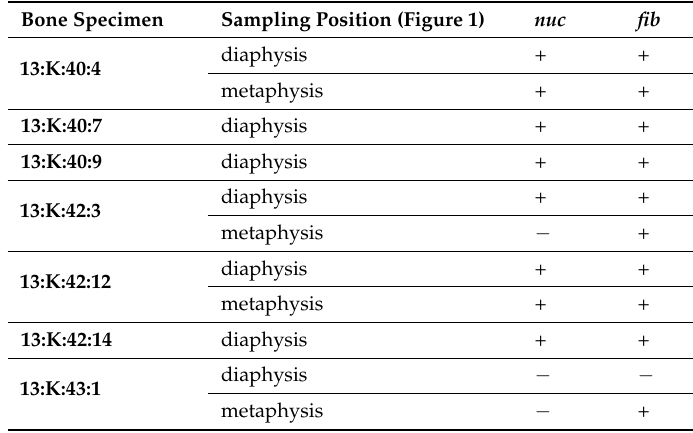
Table 2. Overall amplification success of S. aureus sequences visualized by gel electrophoresis (Figure 2, Supplementary Figures S1 and S2).